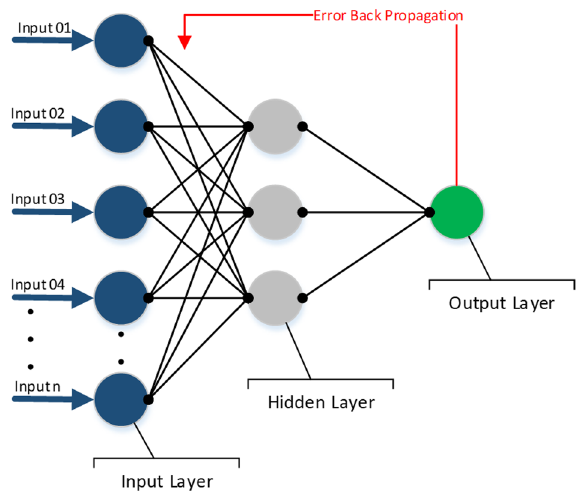
Figure 4. Architecture of ANN classifier for the proposed prediction